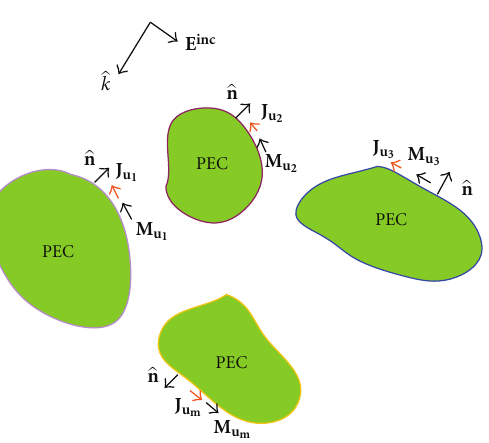
Figure 3: The 3D electromagnetic scattering problem of multiple conducting bodies coated with thin layer